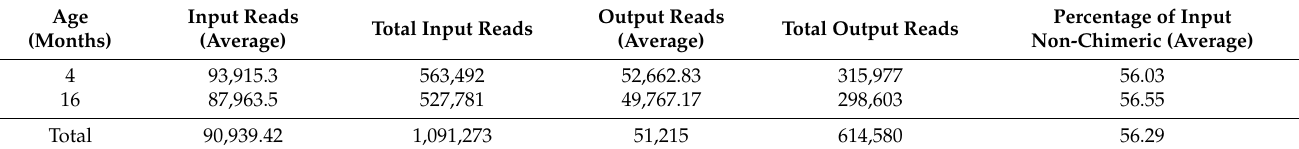
Table 1. Summary of DADA2 sequence data quality